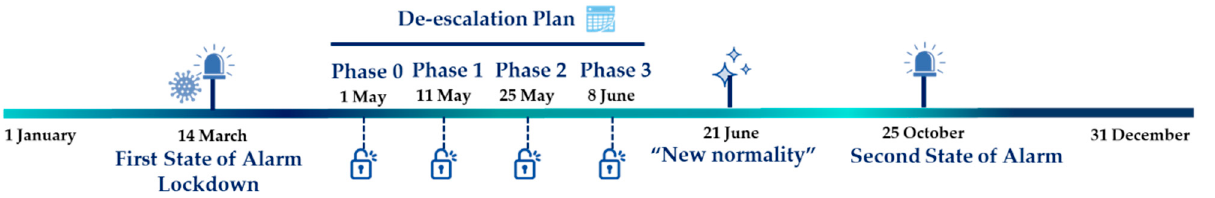
Figure 2. Chronology of the COVID-19 periods in Cantabria (year 2020).